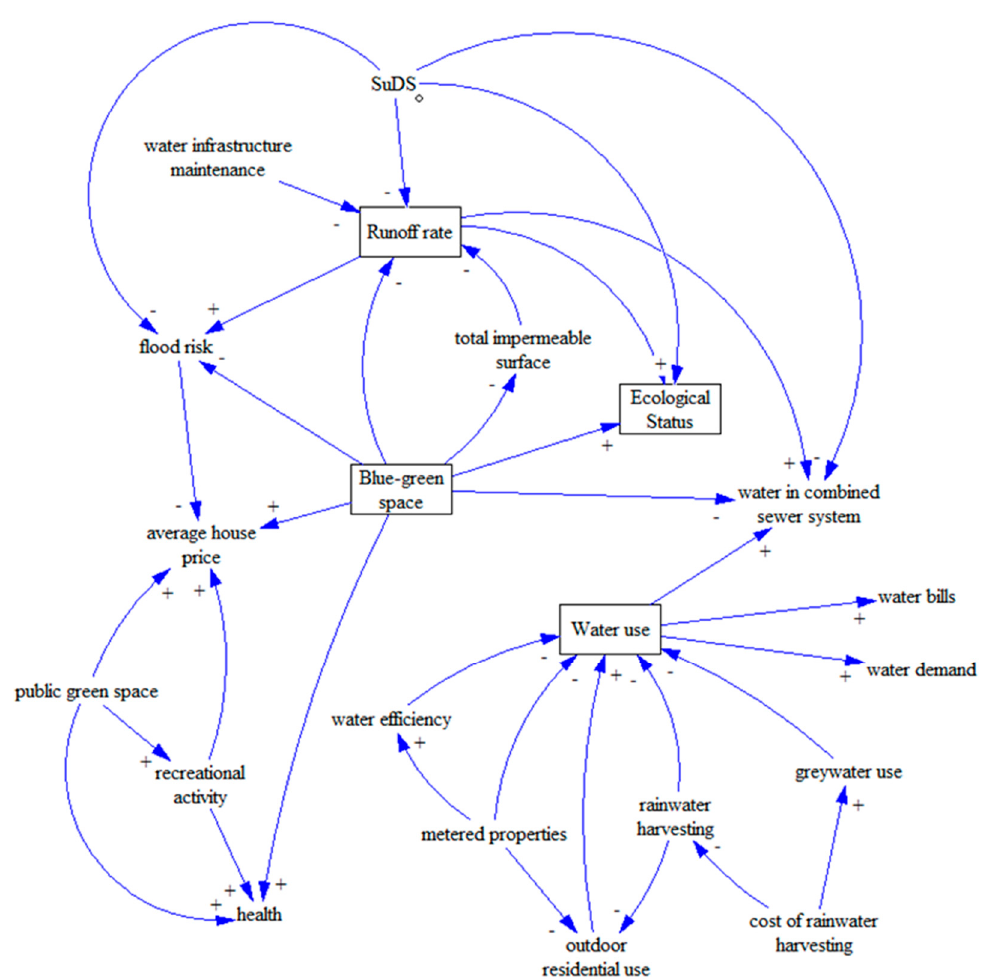
Figure 4. Early version of the causal loop diagram created by the project team and members of the Ebbsfleet Water Forum illustrating variables and linkages in response to a discussion of sustainable water management options for the Ebbsfleet Garden City.